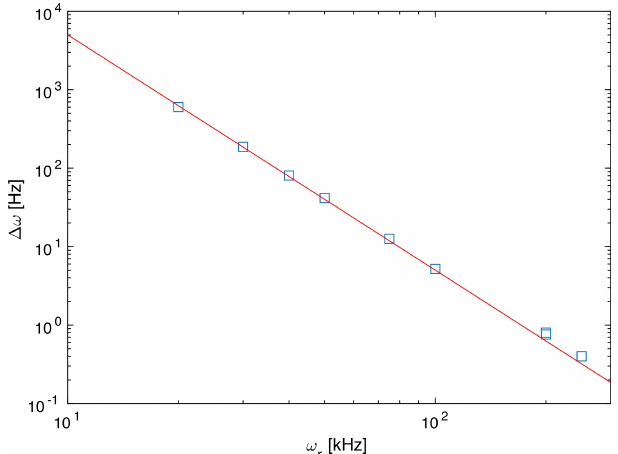
Figure 3. Difference in breadth of the simulated spectra between the third-order and exact effective Hamiltonians as a function of the spinning frequency. The red line has a slope of − 3 corresponding to a ω − 3 r dependence of the difference. This is the expected slope for a contribution by a fourth-order effective